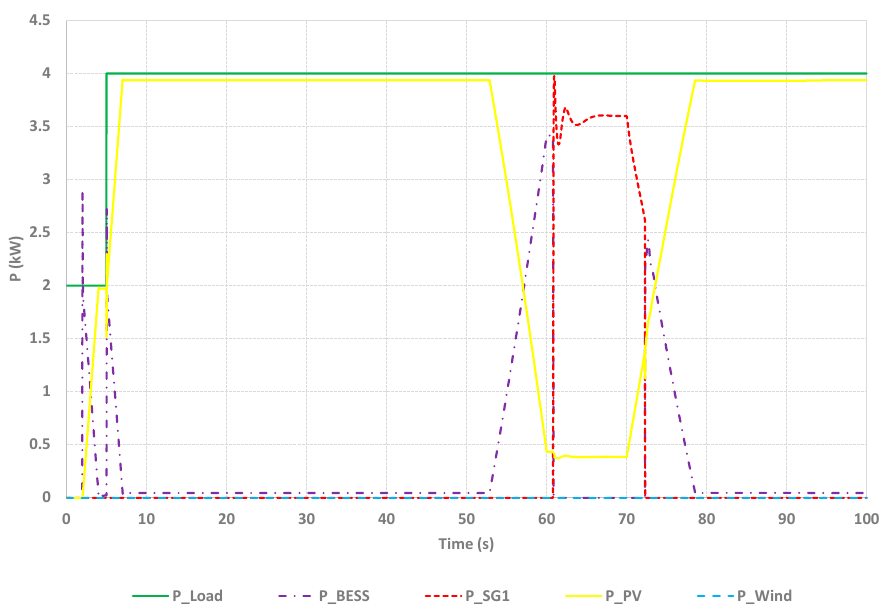
Figure 15. Scenario 4a: Cloud transient analysis for maximum solar PV generation and zero wind generation for a 4 kW demand with the BESS.